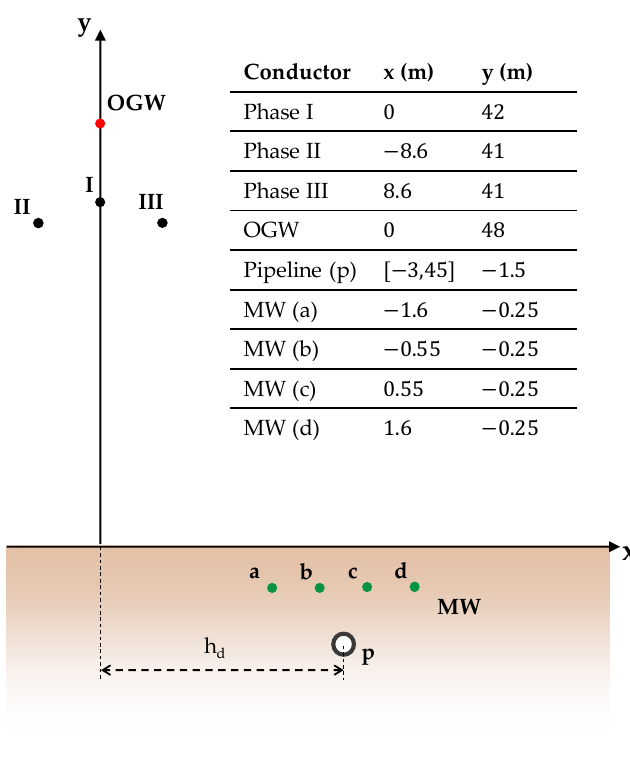
Figure 2. Geometric characteristics of the considered power line, pipeline and mitigation